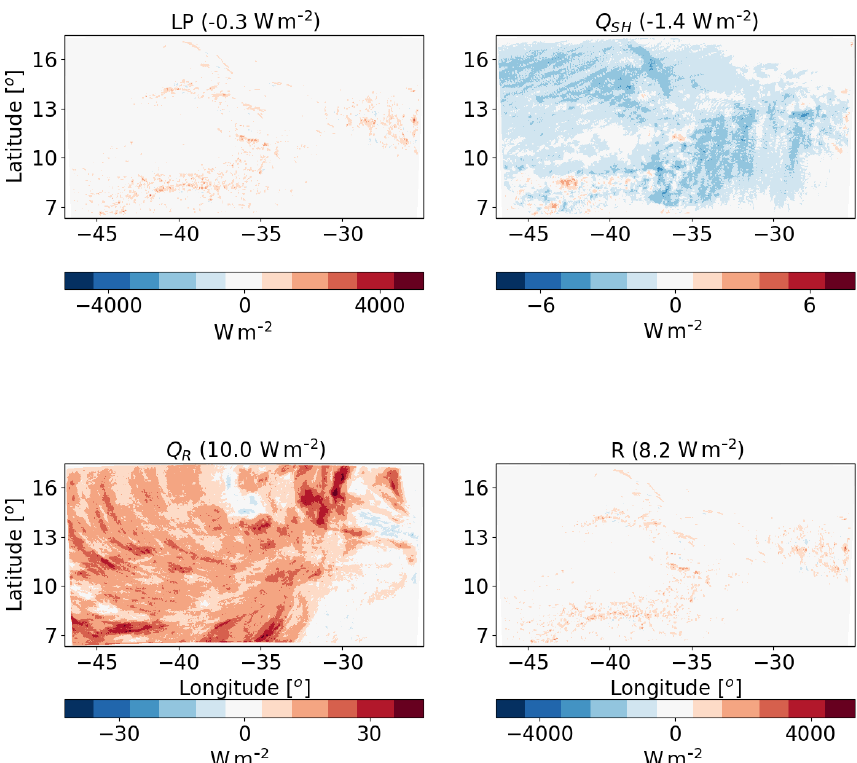
Figure 14. The differences between polluted (CDNC = 200cm − 3 ) and clean (CDNC = 20cm − 3 ) ICON simulations of the time-mean terms of the energy budget for the deep-cloud-dominated case (16–18 August 2016). The terms that appears here are as follows: LP – latent heat by precipitation, Q SH – sensible heat flux, Q R – atmospheric radiative warming – and R – the energy imbalance. The domain- and time-mean value of each term appear in